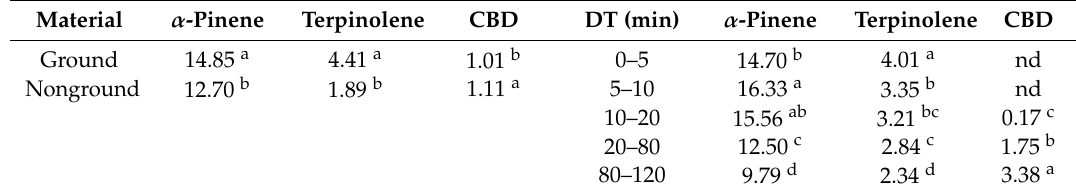
Table 6. Mean concentrations of α -pinene, terpinolene, and cannabidiol (CBD) obtained from the 2 materials and the 5 distillation times